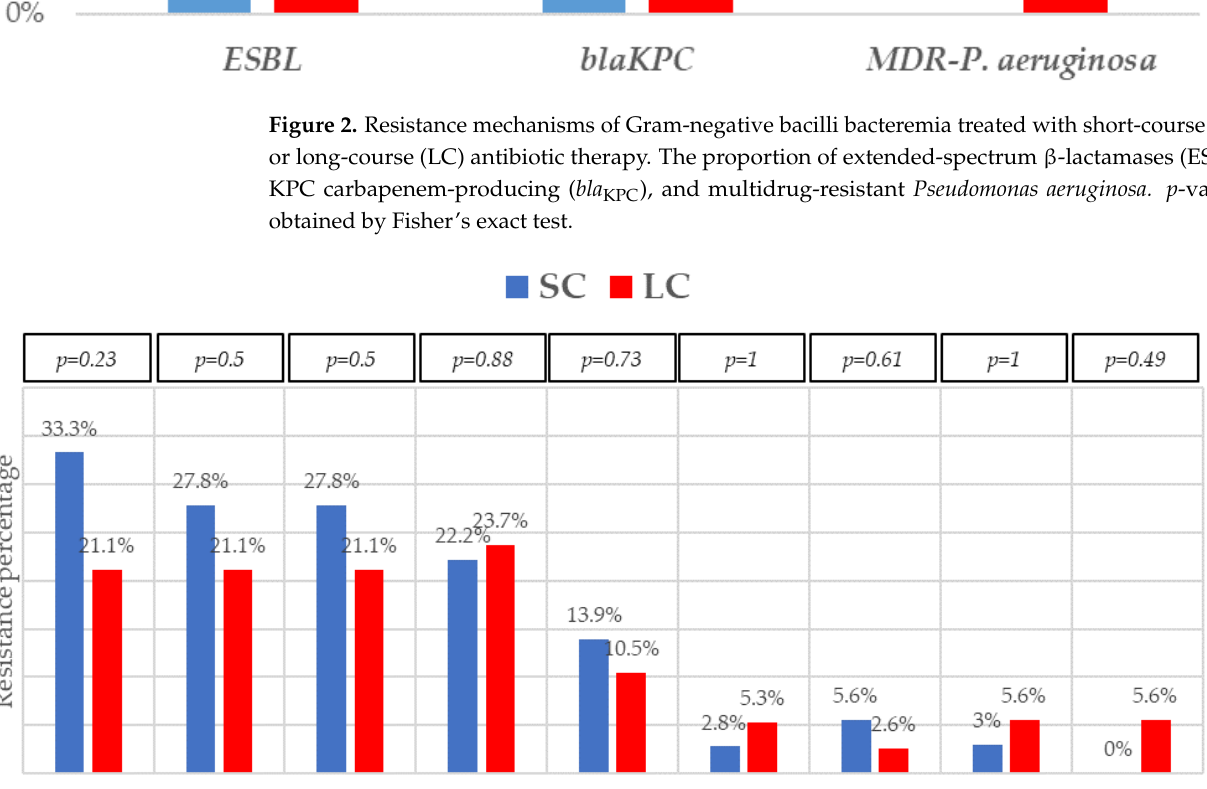
Figure 3. Resistance profile of Gram-negative bacilli bacteremia treated with short-course (SC) or long- course (LC) antibiotic therapy. Abbreviation: pip-taz, piperacillin-tazobactam. * Data obtained from Enterobacterales isolates (except P. aeruginosa ). p -values obtained by chi-square or Fisher’s exact